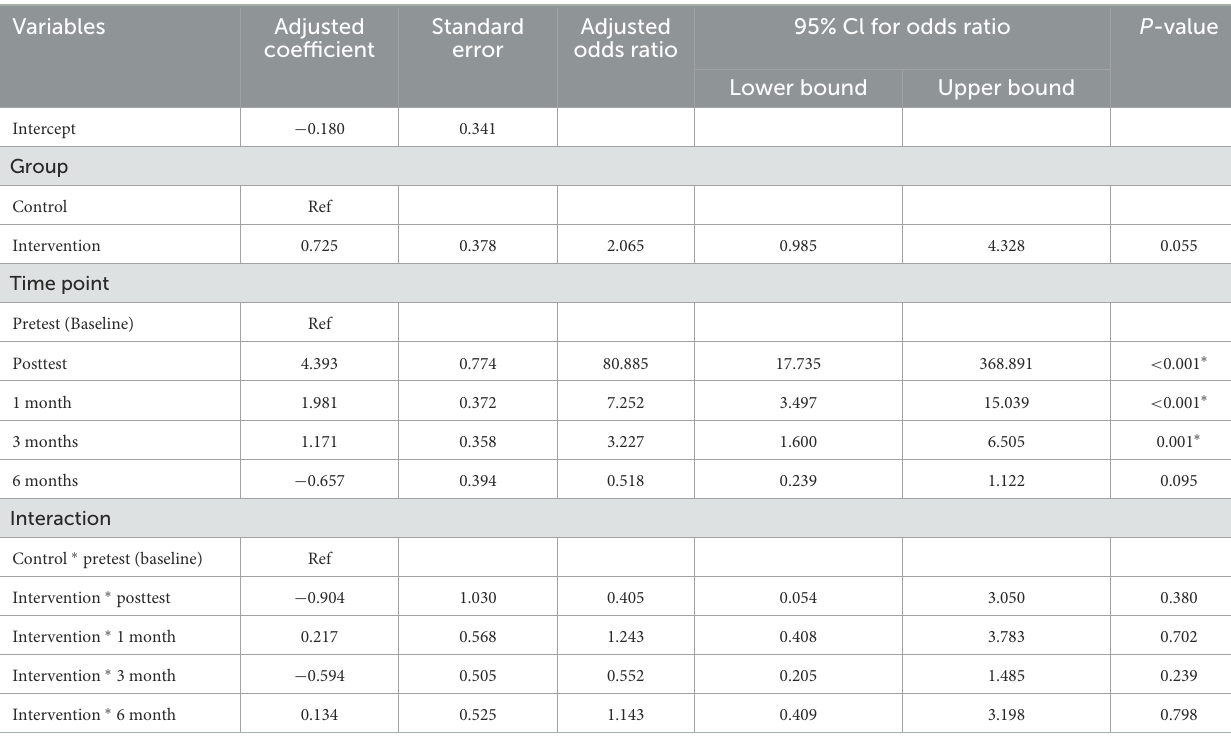
group) on skills retention, adjusted with covariates. As for the skills, the probability of having good skills was not significant differences between the two groups (AOR = 1.749, 95% CI: 0.863, 3.547, p = 0.121). Nurses at the posttest (AOR = 104.217, 95%CI: 15.124,